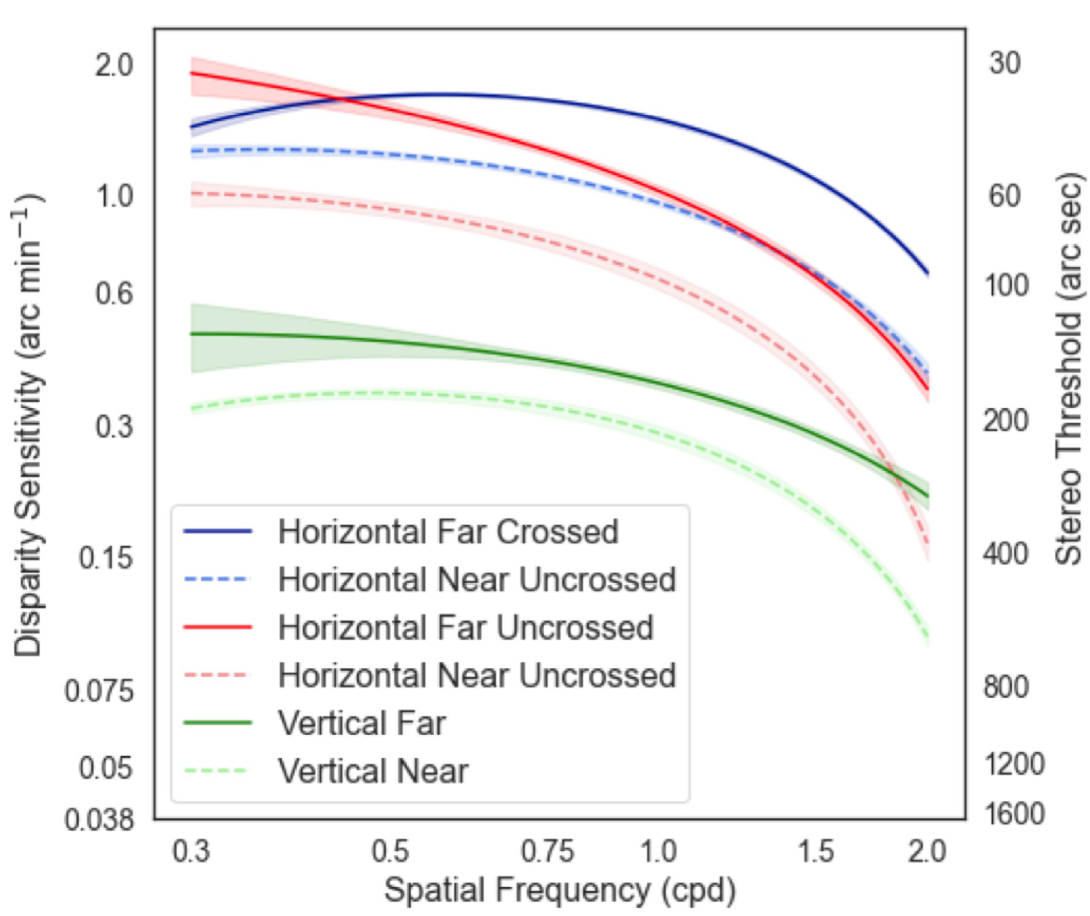
Fig 6. Disparity Sensitivity Function (DSF) for the vertical disparity. The red and blue solid and dashed lines are the results from six subjects for crossed and uncrossed horizontal disparity at near and far. The solid green line is the DSF curve for vertical disparity at far while the dashed green line is for the near condition. The vertical DSFs were significantly lower. The subjects were less sensitive to vertical than horizontal disparity. The shaded region denotes the 95% confidence interval from bootstrap resampling (1000 repeats).